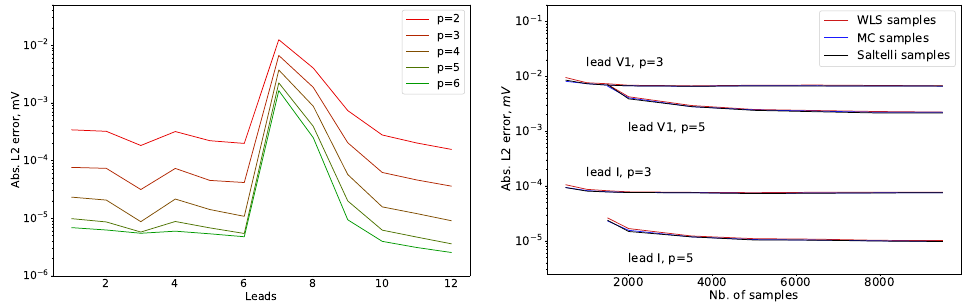
Figure 5. Error convergence for PCE surrogate models. ( Left ): Convergence of the absolute L 2 error with polynomial order p for the Monte–Carlo sampled dataset, shown for all 12 leads. ( Right ): The model error convergence with sample size for all DSs with high input variability. Shown are four different cases: Lead V1 with generally higher approximation errors, compared to lead I for two different orders of approximation, p = 3 and p = 5. The saturation of the errors with sample size indicate that enough samples were used for the chosen polynomial order. Note that the higher polynomial order leads to smaller approximation errors but more samples are needed for the error to saturate at its minimum value. We observe only minor differences with respect to the sampling scheme used with very slight systematic advantages of the Saltelli samples and slightly higher errors for the WLS-optimized sampling, when compared to the Monte–Carlo sampling